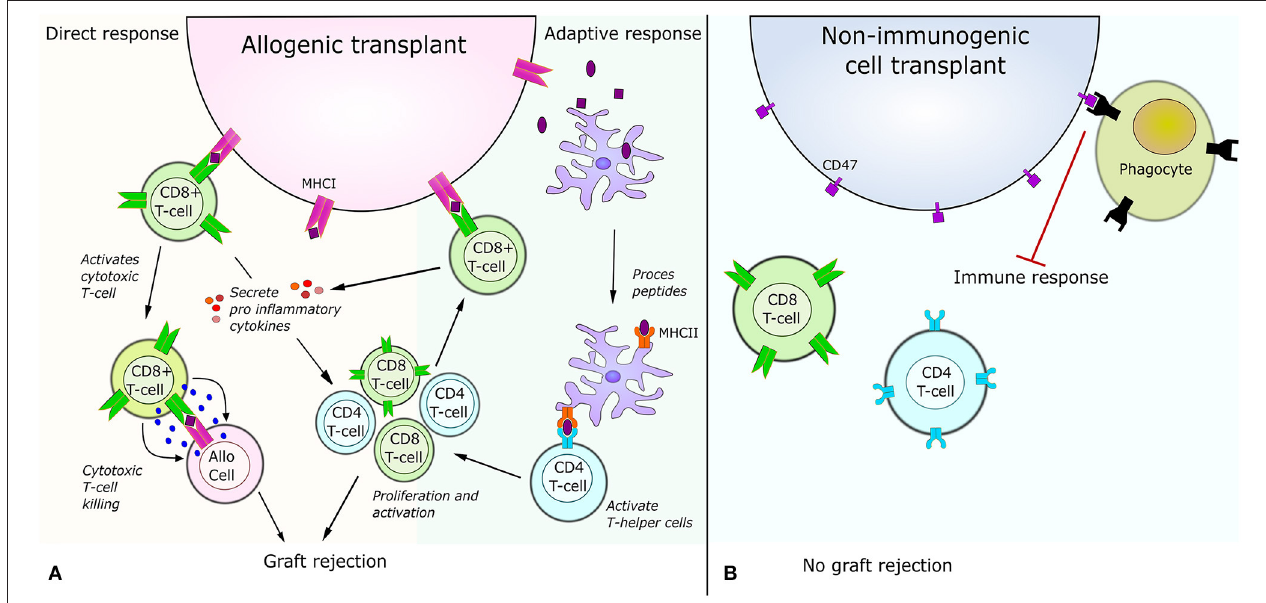
FIGURE 2 | Immune response for allogenic cell transplant vs. non-immunogenic cell transplant. (A) Illustration of the immune responses triggered by allogenic transplants. The direct response is caused by CD8 T-cell receptor recognition of a foreign peptide presented by MHCI. This recognition activates the cytotoxic T-cell killing of the allogenic cell and results in secretion of pro-inflammatory molecules amplifying the immune response. The adaptive immune response is caused by antigen presenting cells engulfing peptides from the allogenic cell. After peptides are engulfed, the antigen presenting cell process the peptide and present part of the peptides to helper T-cells via the MHCII. The interaction between helper T-cells and MHCII results in activation and proliferation of CD4 helper T-cells and CD8 T-cells. The activated CD8 T-cells can then recognize peptides presented on the allogenic cells’ MHCI and cause a direct response. (B) Illustration of the immune response triggered by allogenic transplants with non-immunogenic stem cells. After knock-out of MHCI and MHCII no immune response occurs via the direct or indirect pathway shown to the left. Additionally, over-expression of CD47 on the cell surface acts as a “do not eat me” signal, which further inhibits an immune